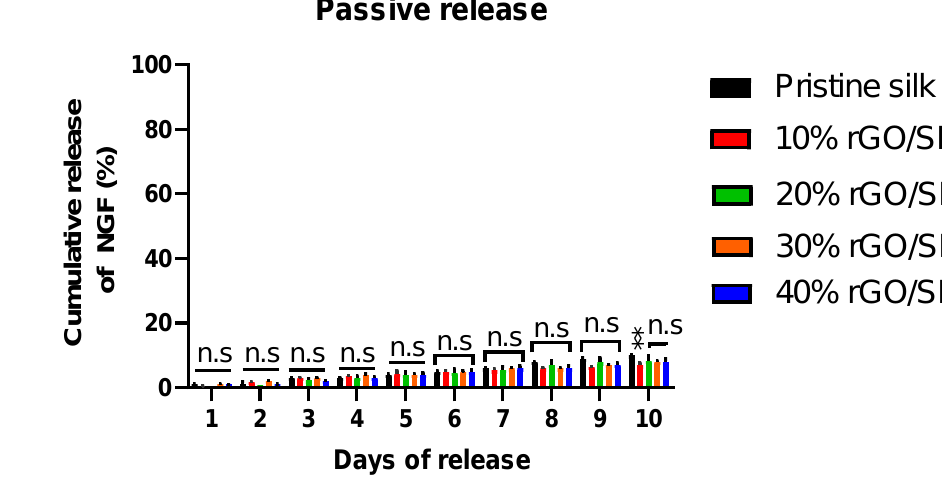
Figure 2. Delivery of nerve growth factor-β (NGF-β) from electroconductive/active silk-based scaffolds. Cumulative release percentage from the films ( n = 3 per type) with passive release. The differences between the experimental groups were analyzed by two-way ANOVA using Tukey’s post hoc test for multiple comparison ( p -value with respect to pristine silk). n.s, nonsignificant; ** p < 0.01.